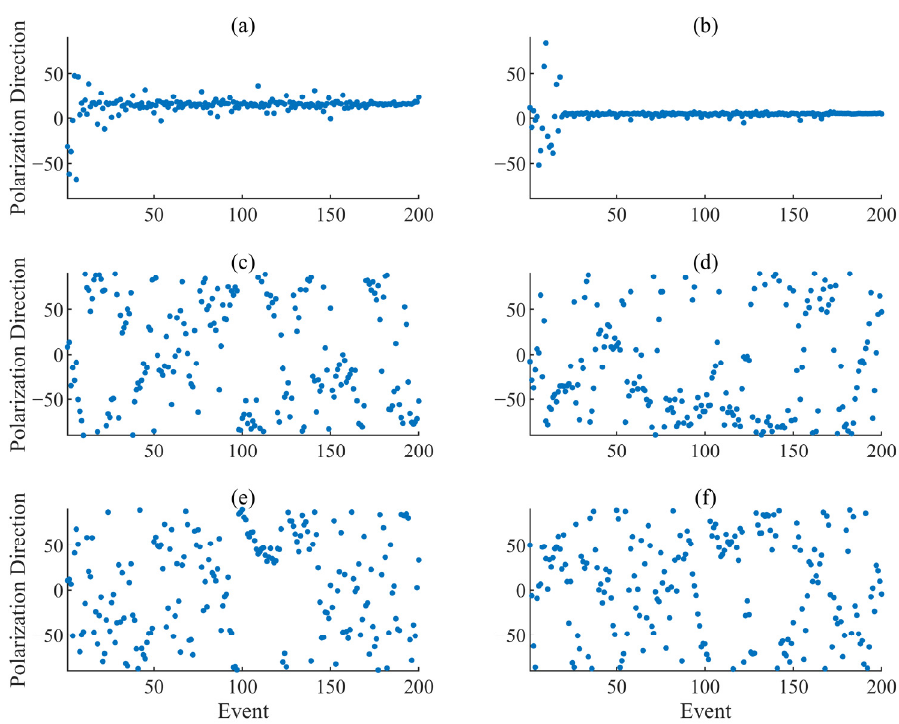
Figure 18. The polarization direction of the test dataset. The electric field of ( a ) noisy data, ( c ) noise-free data, and ( e ) denoised data at 0.075 Hz. The magnetic field of ( b ) noisy data, ( d ) noise-free data, and ( f ) denoised data at 0.075 Hz.